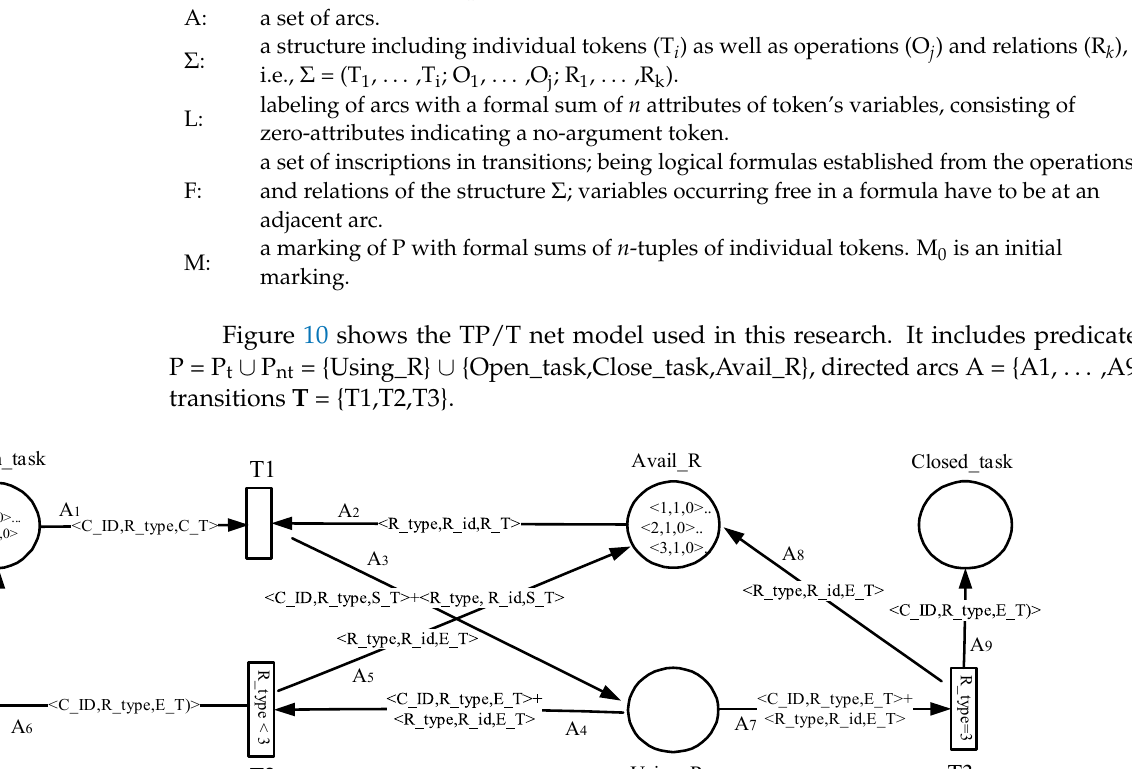
Table 2. The parameter setting for YC, YT and QC.